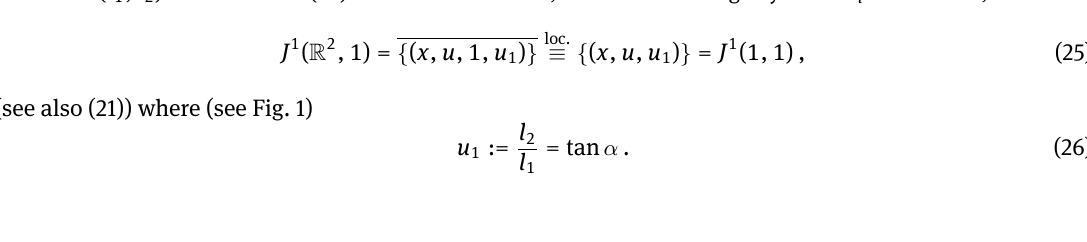
Fig. 1. Save for the vertical, all lines in R 2 = { ( x , u ) } are unequivocally labeled by tan α